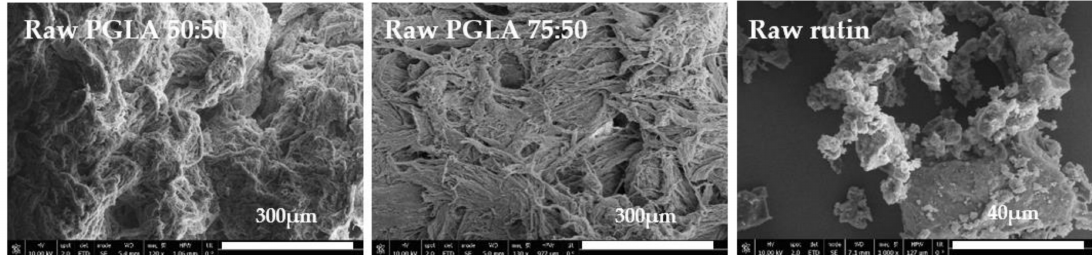
Figure 10. SEM images of raw PGLA and raw rutin.